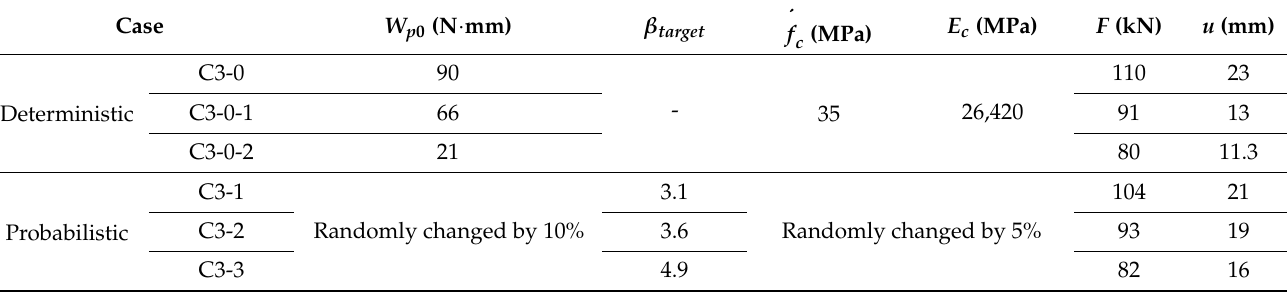
Table 4. Results obtained from C3 model.